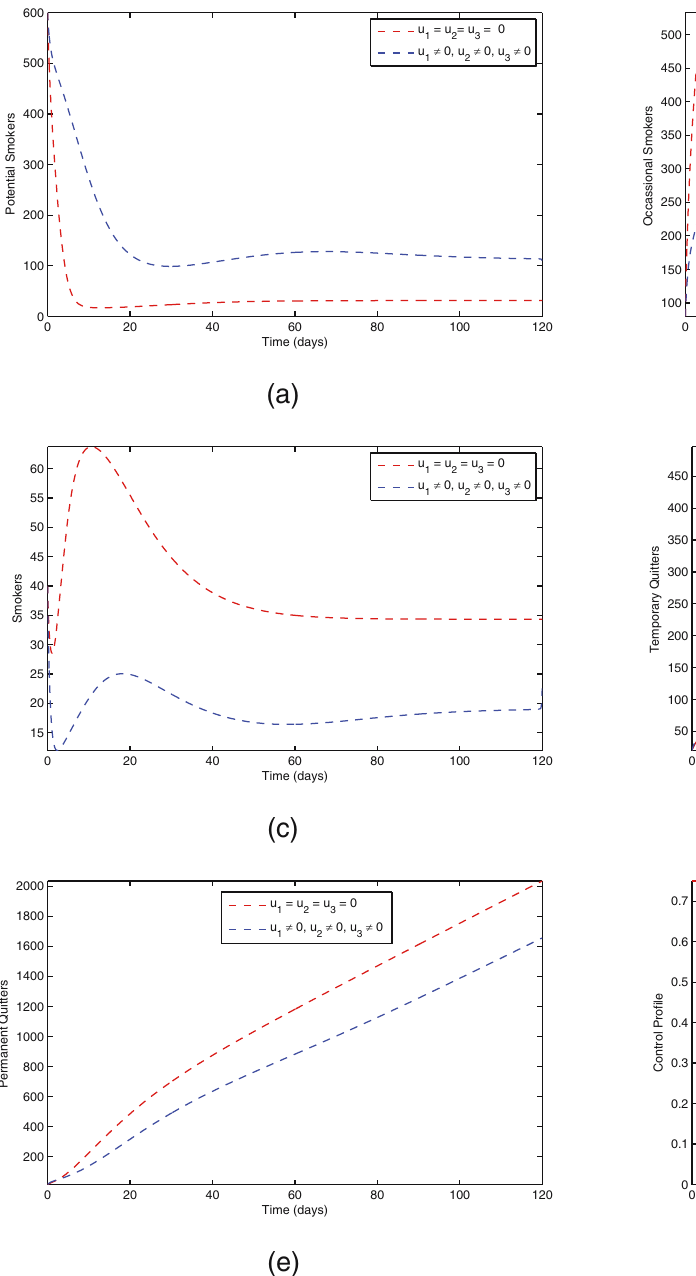
Figure 8: Controls applied to the population ( from a – f )